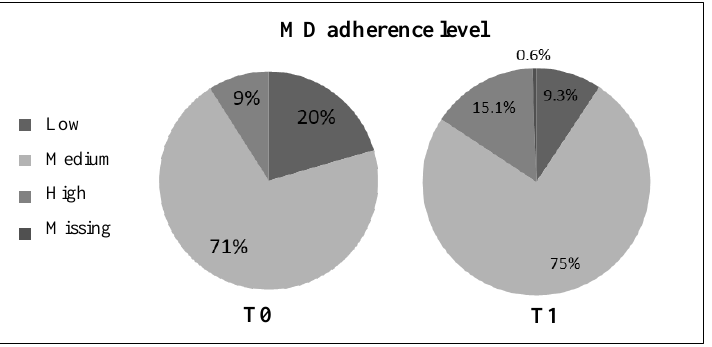
Figure 2. MD adherence level of peri- and post-menopausal women, at T0 (N = 200) and T1 (N = 171). Mean score of MD adherence at T0 and T1 was respectively 6.98 ± 1.74 and 7.53 ± 1.68. Paired sample t-test revealed a statistically significant difference between T0 and T1 ( p < 0.001), so MD score increased (Figure 3). In particular, the consumption of veg- etables and nuts significantly increased (respectively, p = 0.003 and p = 0.037), and daily calcium rich mineral water increased significantly ( p < 0.001).